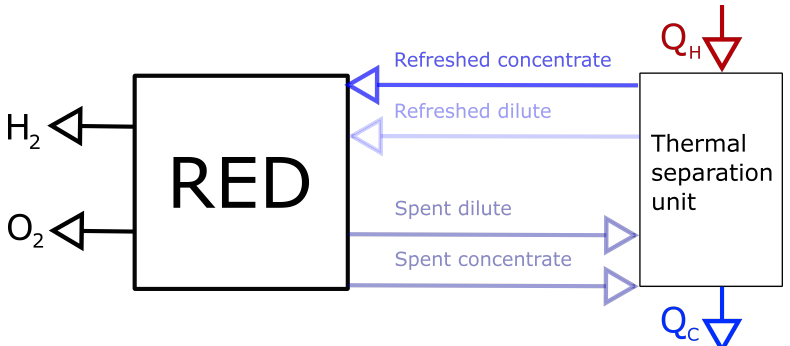
Figure 1. Reversing the spent concentrations from RED using a thermal separation unit.